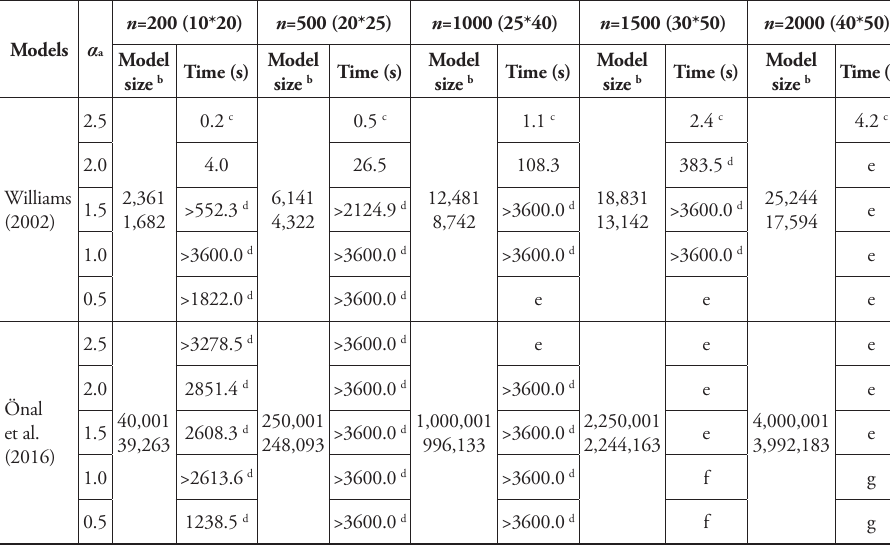
Table 3. Computational efficiency of Williams (2002) and Önal et al. (2016) models in solving large- scale contiguity problems. Models α